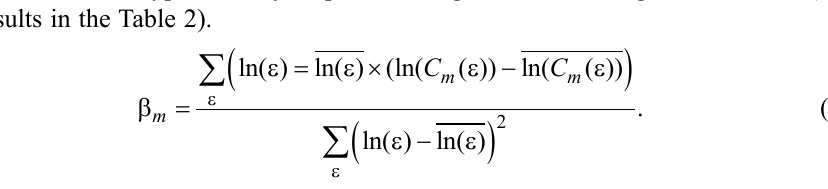
Table 2. Power test of slope coefficient b